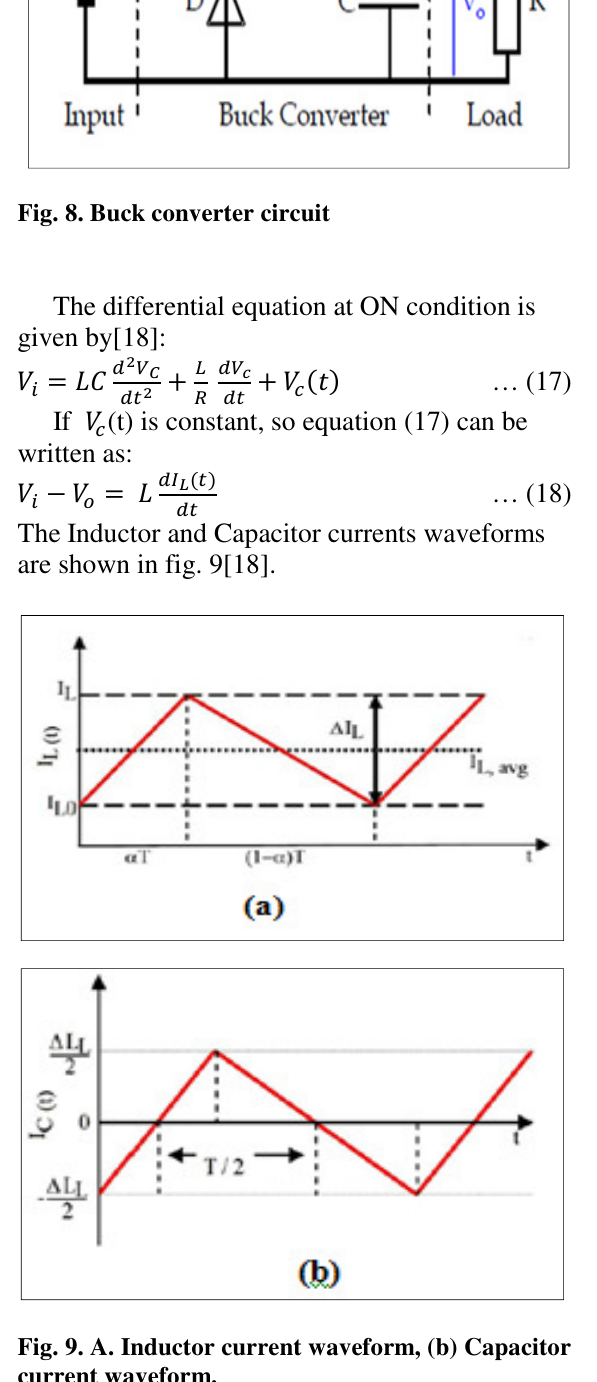
Fig. 9. A. Inductor current waveform, (b) Capacitor current